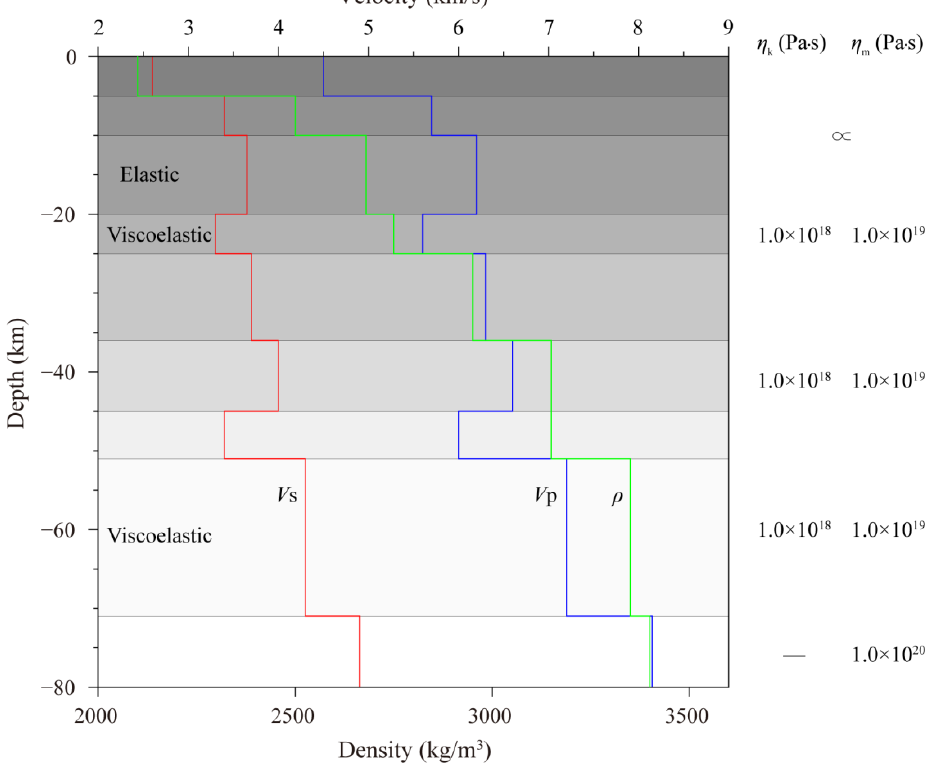
Figure 2. Parameters in the stratified viscoelastic relaxation model. V p indicates the P wave velocity, V s the S wave velocity, and ρ the density; η k and η m represent the viscosity of the dashpots in the Kelvin material and the Maxwell material, respectively. Kelvin material and the Maxwell material,